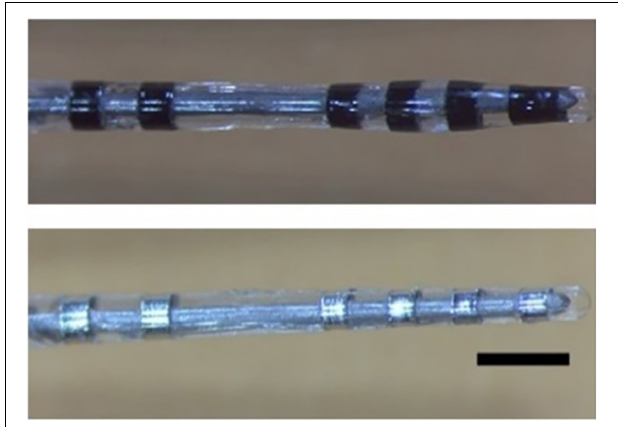
FIGURE 1 | Rat DBS electrode arrays, uncoated (top) and CH-coated (bottom) (scale bar, 1 mm).